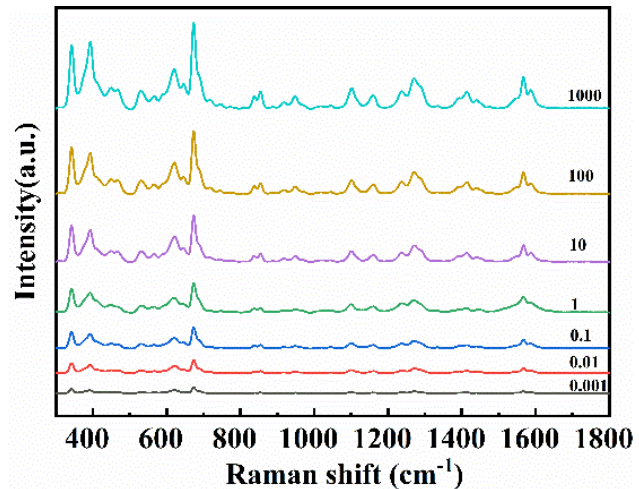
Figure 8. SERS spectra of apple surface samples treated mixed pesticide.